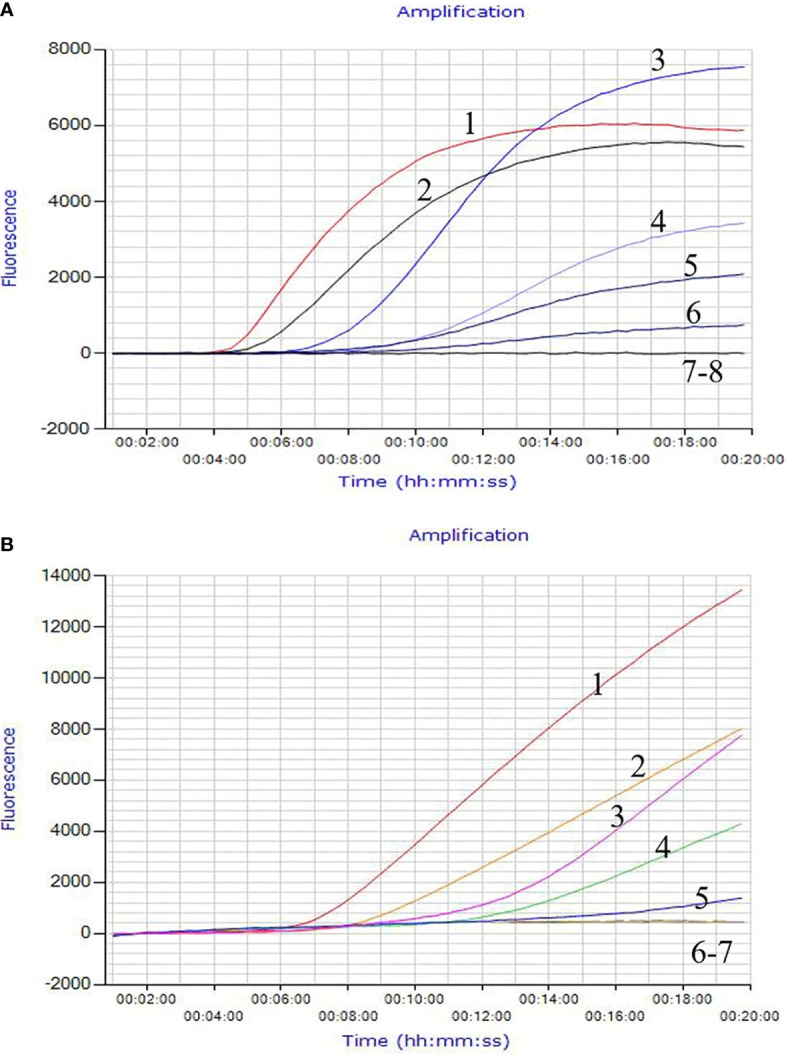
Analytical Sensitivity of the real-time RPA assay. The LOD of the real-time RPA was 1.1 × 101 fg/μl of Salmonella spp. standard DNA and 1.4 × 102 CFU/ml for bacteria in pure culture. Fluorescence development over time using a dilution range of 1.1 × 106–1.1 × 100 fg of Salmonella spp. genomic DNA. For (A): Curve 1, 1.1 × 106 fg; Curve 2, 1.1 × 105 fg; Curve 3, 1.1 × 104 fg; Curve 4, 1.0 × 103 fg; Curve 5, 1.1 × 102 fg; Curve 6, 1.1 × 101 fg; Curve 7, 1.1 × 100 fg; Curve 8, ddH2O. For (B): Curve 1, 1.4 × 106 CFU; Curve 2, 1.4 × 105 CFU; Curve 3, 1.4 × 104 CFU; Curve 4, 1.4 × 103CFU; Curve 5, 1.4 × 102 CFU; Curve 6, 1.4 × 101CFU; Curve 7, 1.4 × 100 CFU.